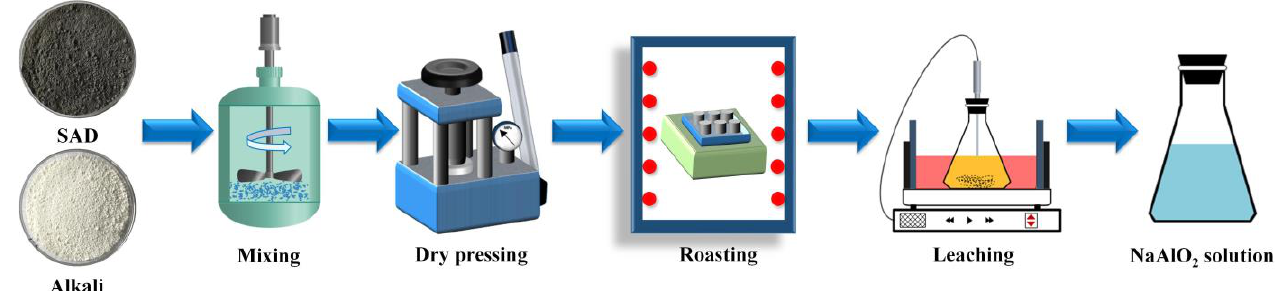
Figure 3. Schematic of the experimental setup and procedure.